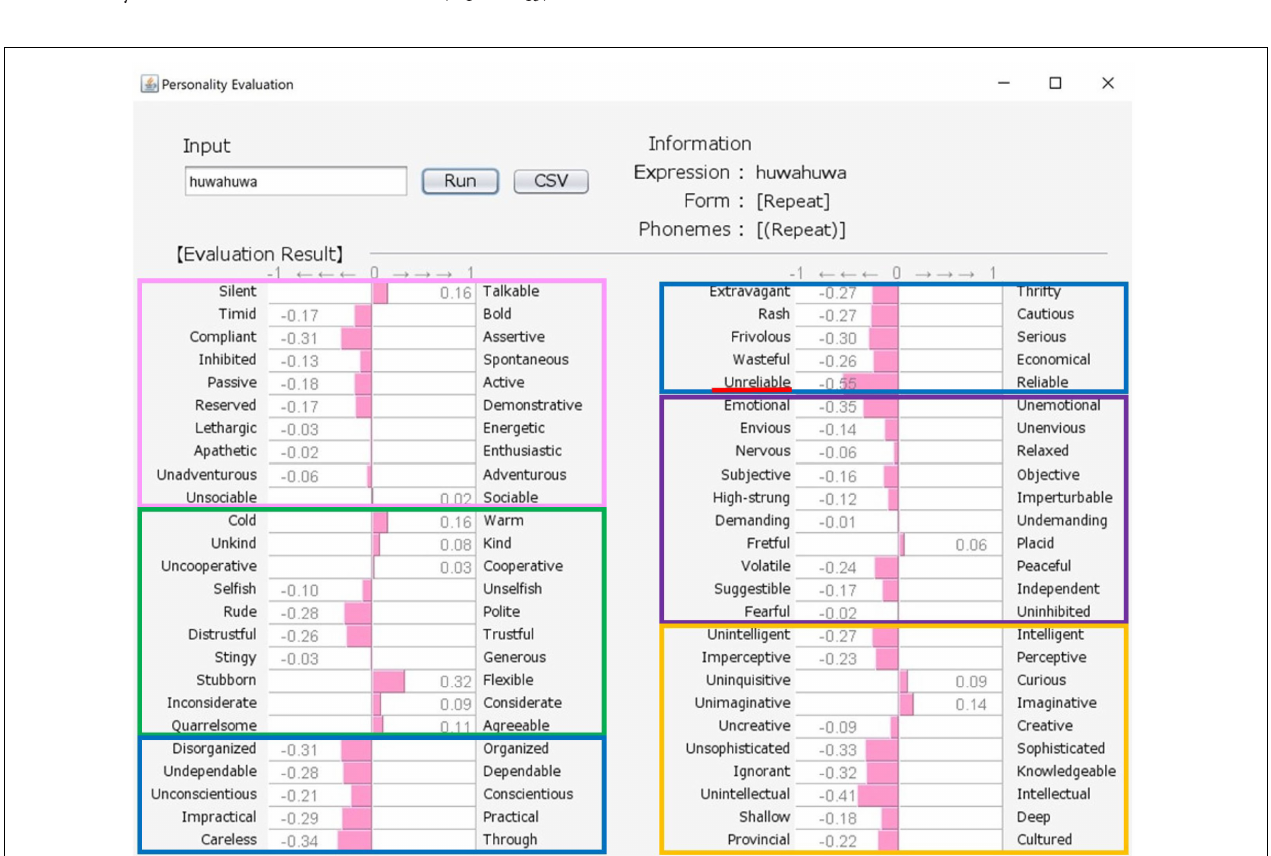
FIGURE 5 | Output for “huwahuwa (nearly equal to fluffy)” personality. The pink, green, blue, purple, and orange frames indicate Extroversion, Agreeableness, Conscientiousness, Neuroticism, and Openness, respectively.